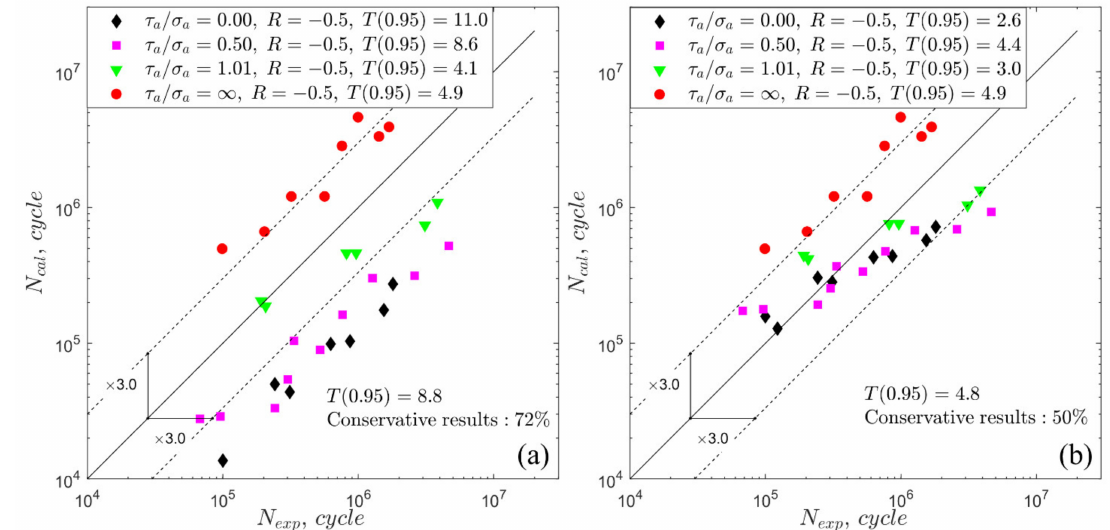
Figure 8. Experimental and calculated fatigue lives for the Crossland model under R = − 0.5 for S355 steel: ( a ) fixed material parameters; ( b ) life-dependent material parameters.